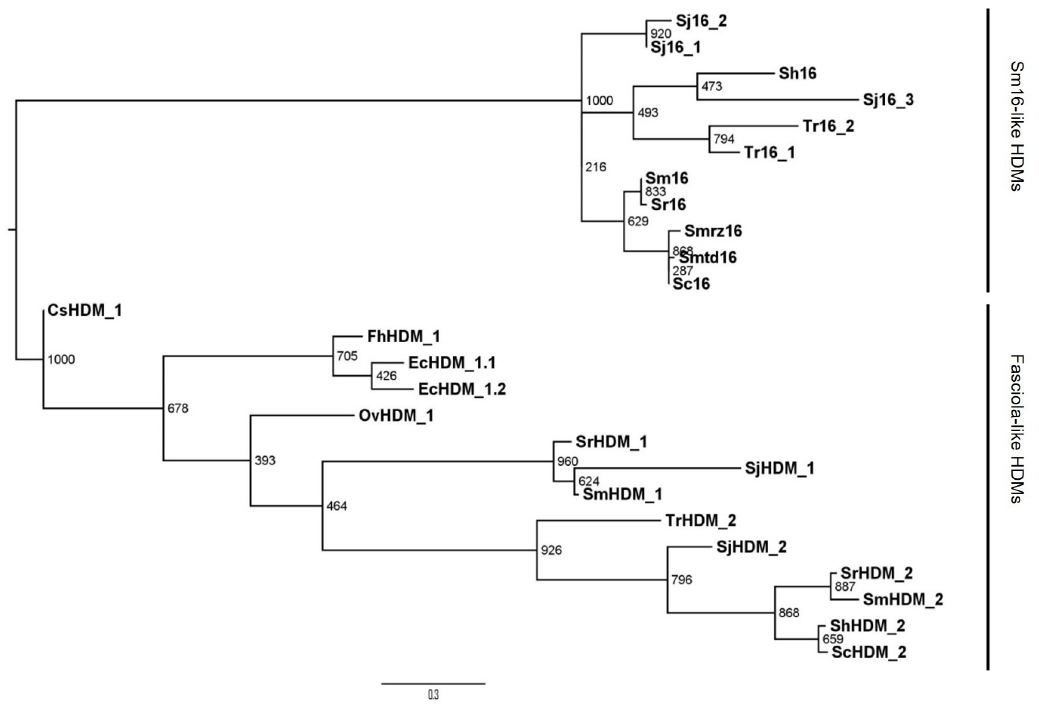
Fig 1. HDMs are a trematode-specific family of immunomodulatory peptides inclusive of Sm16-like molecules. Midpoint- rooted maximum likelihood phylogram of the trematode-specific HDM family generated by PhyML, based on the protein sequence Leu 30 to Lys 87 (FhHDM nomenclature) containing the amphipathic region of the proteins from 12 trematode species: Clonorchis sinensis (CsHDM_1), Echinostoma caproni (EcHDM_1.1 & EcHDM_1.2), Fasciola hepatica (FhHDM_1), Opisthorchis viverrini (OvHDM_1), Schistosoma curassoni (Sc16 & ScHDM_2), S . haematobium (Sh16 & ShHDM_2), S . japonicum (Sj16_1, Sj16_2, Sj16_3, SjHDM_1 & SjHDM_2), S . mansoni (Sm16, SmHDM_1 & SmHDM_2), S . margrebowiei (Smrz16), S . mattheei (Smtd16), S . rodhaini (Sr16, SrHDM_1 & SrHDM_2) and Trichobilharzia regenti (Tr16_1, Tr16_2 & TrHDM_2). The clusters of Sm16-like HDMs and Fasciola -like HDMs are shown. Bootstrap support values (1000 iterations) are shown at each node. Accession number/gene identifiers are presented in S1 Table.